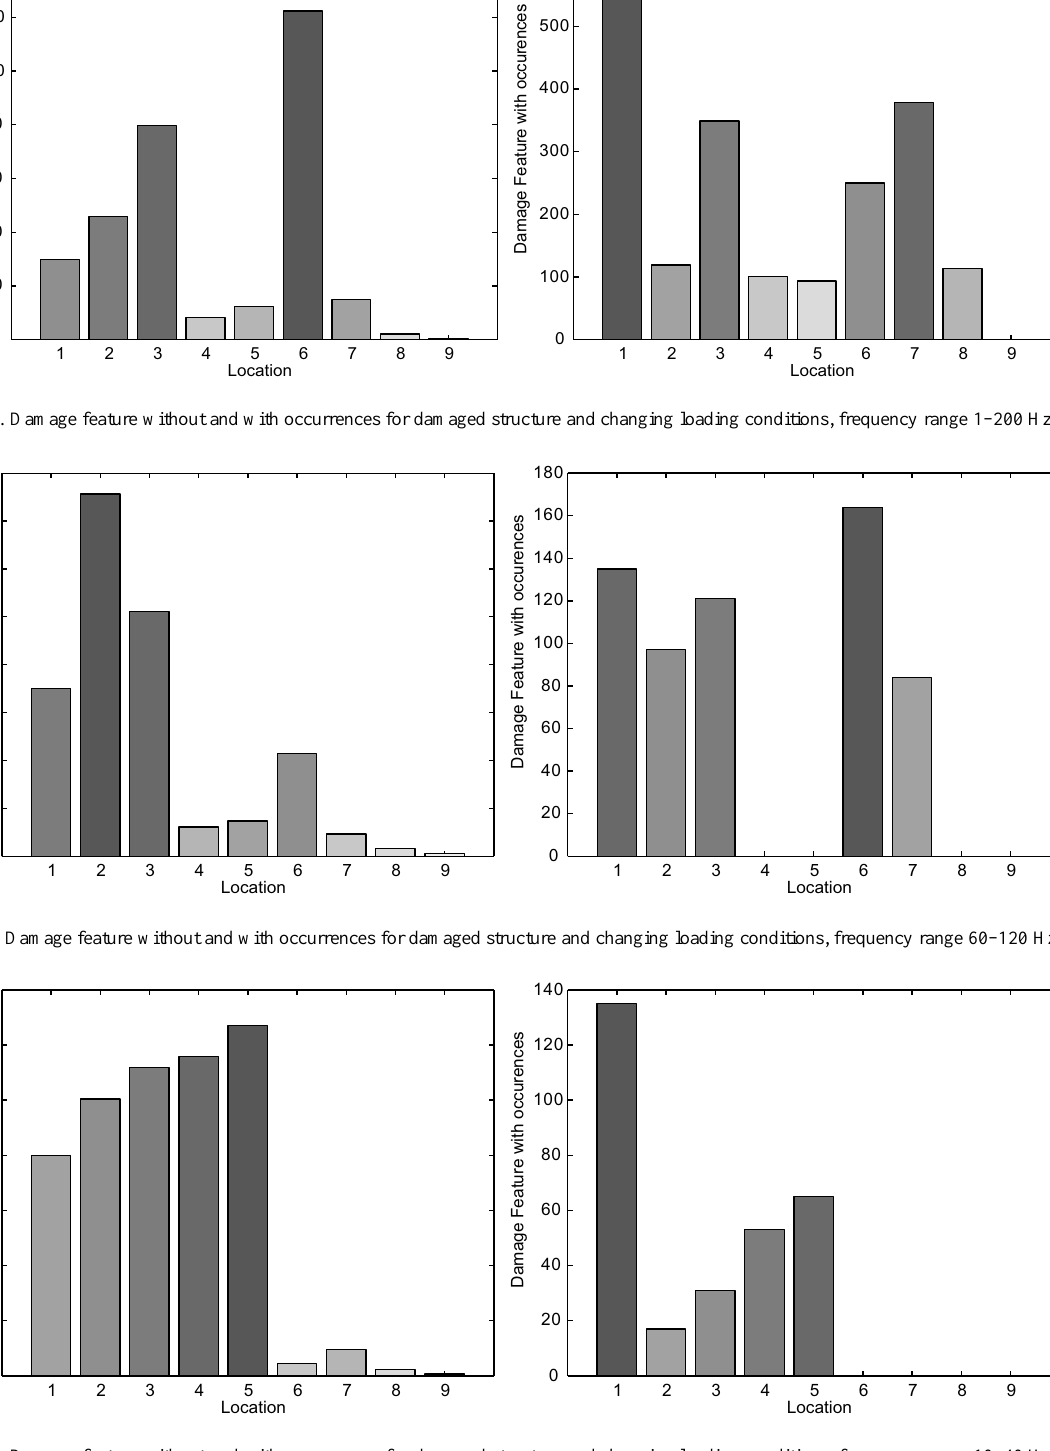
Fig. 14. Damage feature without and with occurrences for damaged structure and changing loading conditions, frequency range 10–40